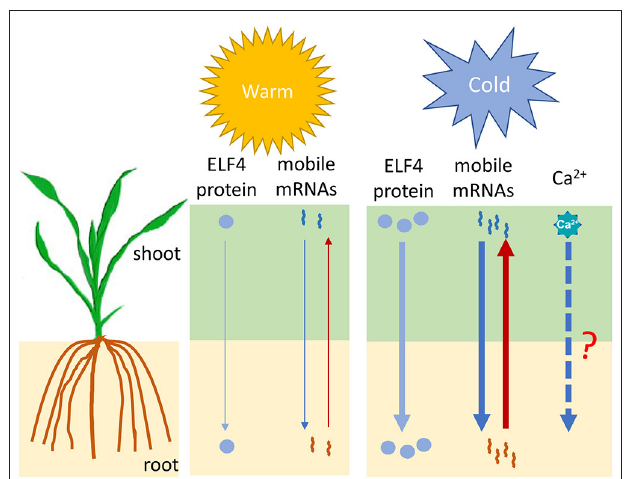
FIGURE 2 | A proposed model for the long-distance regulation of cold signaling by the ELF4 protein and mobile mRNAs. Full and dashed arrows indicate known and potential long-distance signaling molecules, respectively. The thickness of the arrows indicates the relative strength of the signal. ELF4, Early flowering